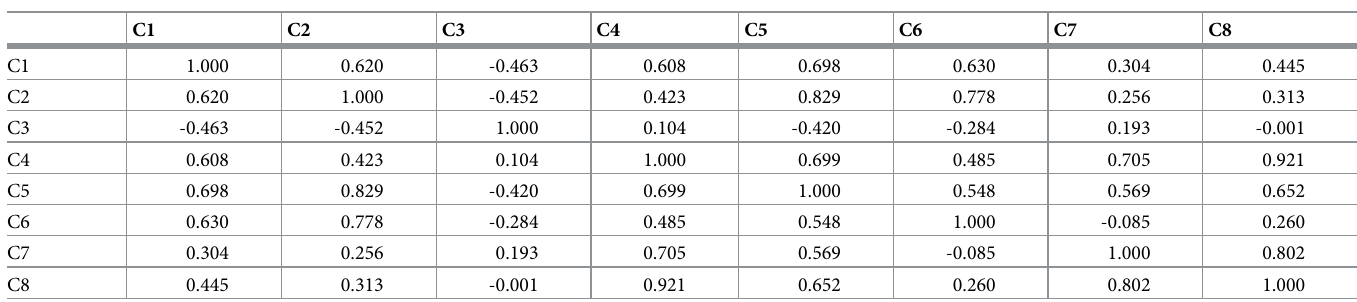
Table 5. Standard deviation σ